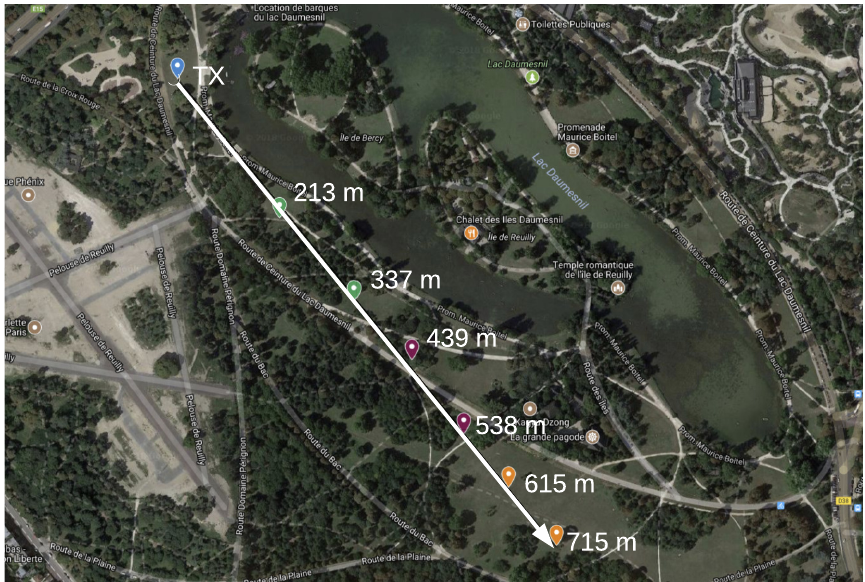
Figure 4. Smart Agriculture scenario.